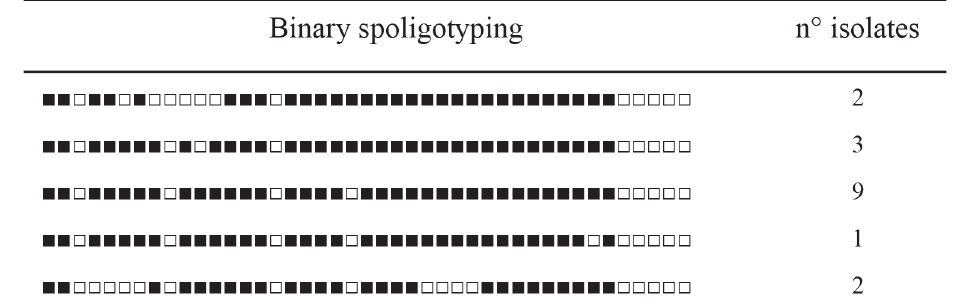
FIGURE 1 - Binary spoligotyping data of 17 Mycobacterium bovis isolates from lymph node samples collected from bovines with macroscopic tuberculous-like lesions or positive skin test during postmortem inspection in an abattoir in the northwestern region of Paraná State,